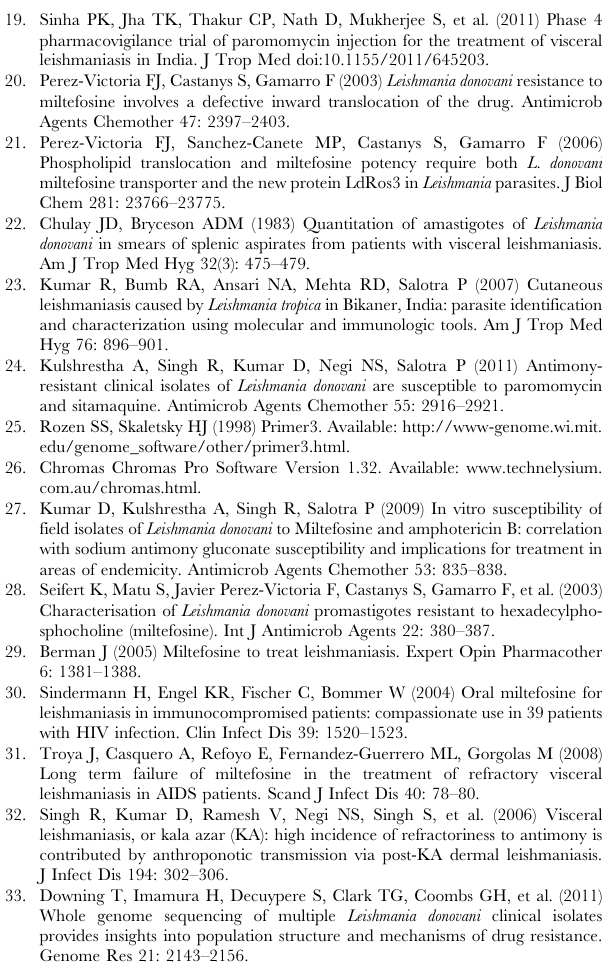
Figure S1 Alignments of sequences for four mutations in